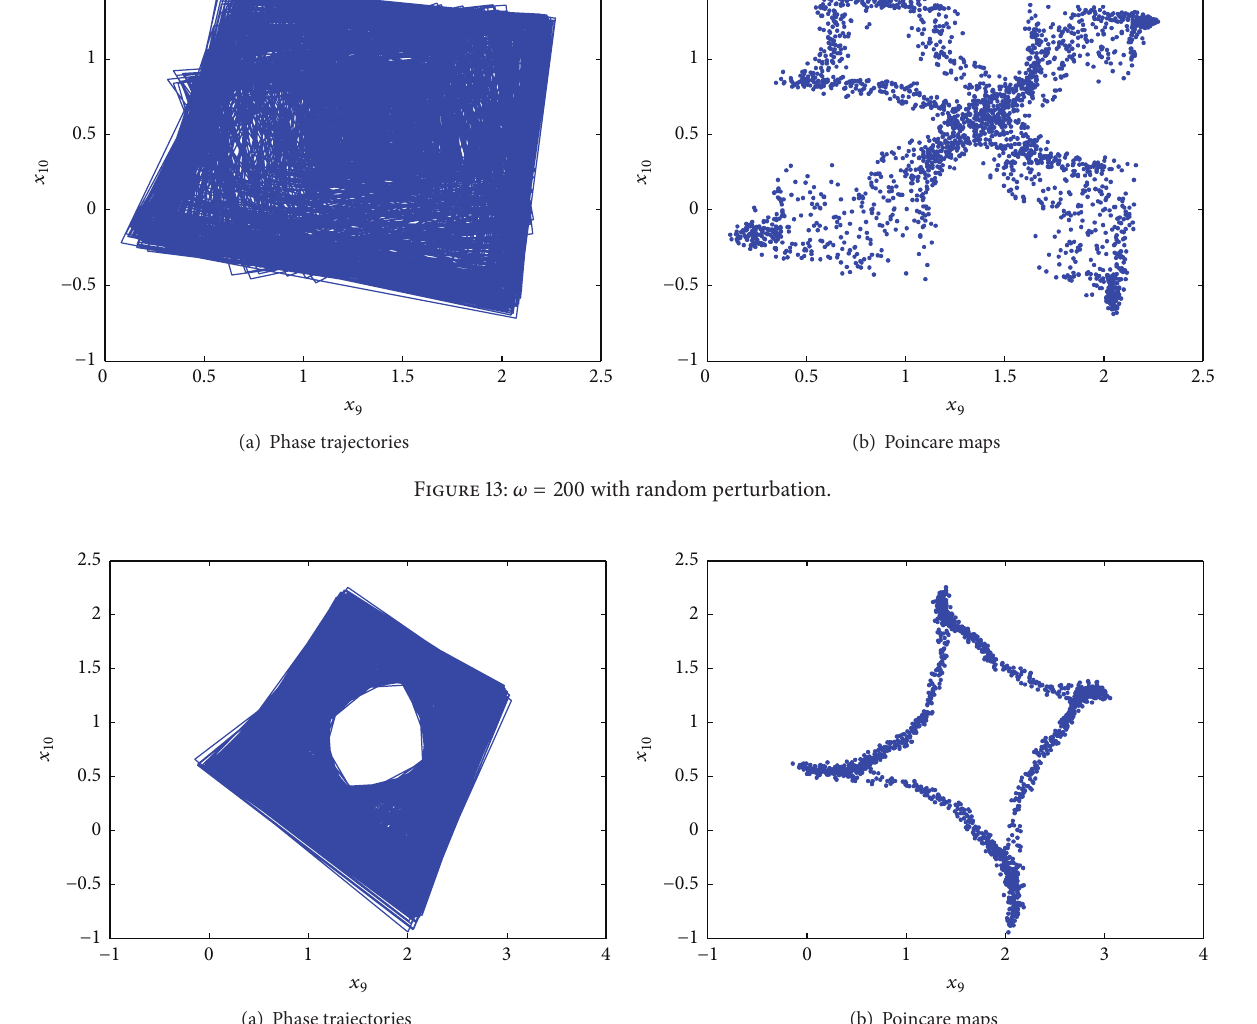
Figure 14: 𝜔 = 240 with random